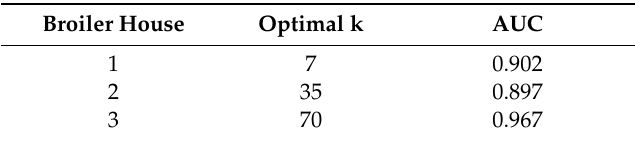
Table 2. Percentages of variances explained by the first two principal components for the cycles in the Table 3. K-nearest neighbors parameter (k) computed and optimized on the training set and the area training set. under the curve (AUC) computed on the test